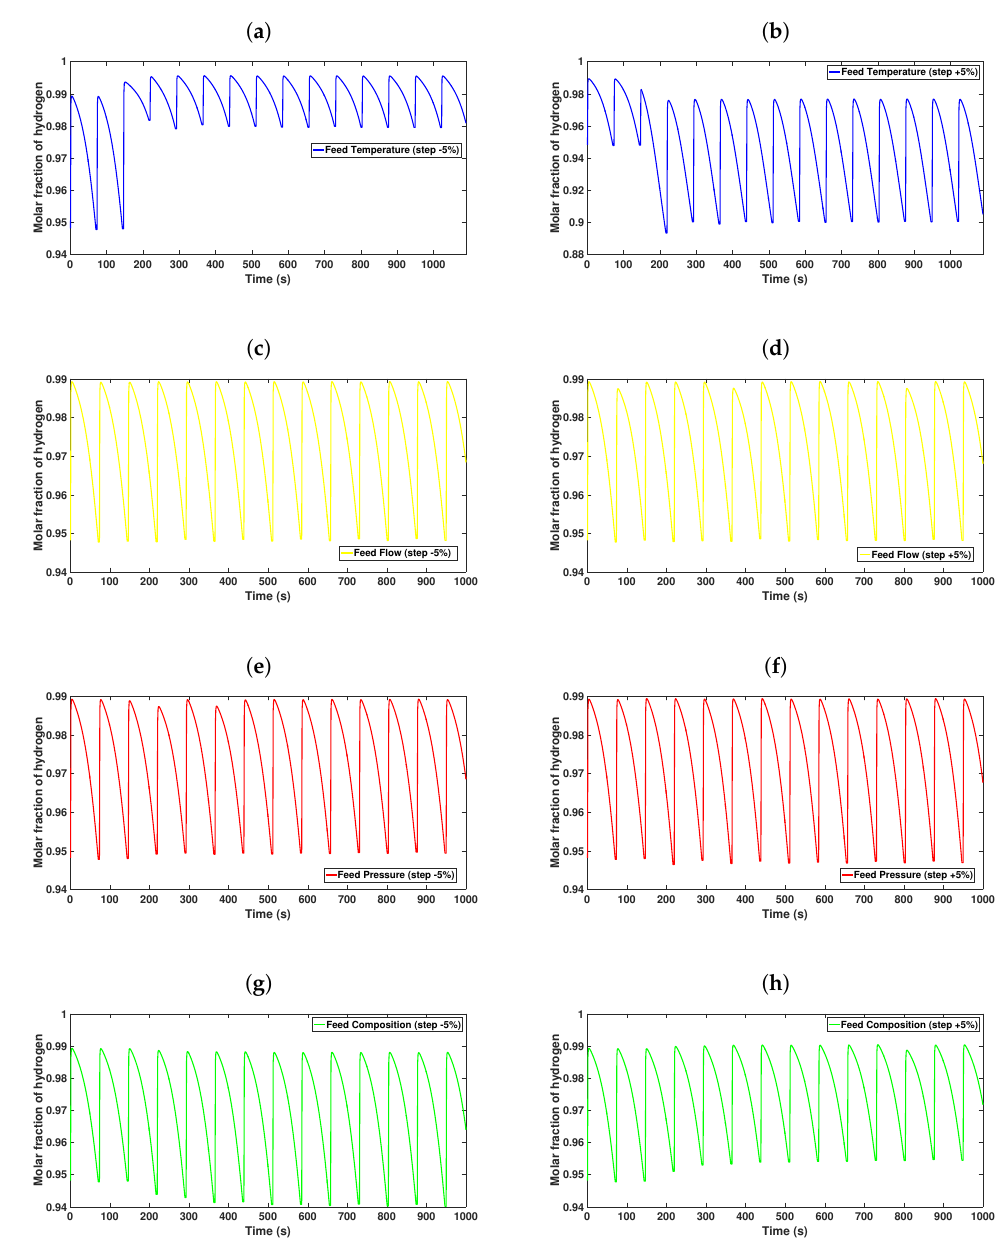
Figure 5. Results of the sensitivity analysis to define the possible input variables that can control the purity of hydrogen. ( a ) Purity obtained using 283 K. ( b ) Purity obtained using 313 K. ( c ) Purity obtained using 0.153 kg h − 1 . ( d ) Purity obtained using 0.170 kg h − 1 . ( e ) Purity obtained using 931 kPa. ( f ) Purity obtained using 1029 kPa. ( g ) Purity obtained using 0.6405 hydrogen, 0.2495 methane, and 0.11 CO. ( h ) Purity obtained using 0.5795 hydrogen, 0.0.3105 methane, and 0.11